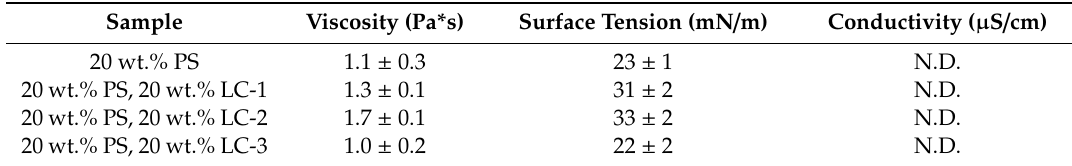
Table 3. The 20 wt.% PS, 20 wt.% LC blend solution properties for three LC